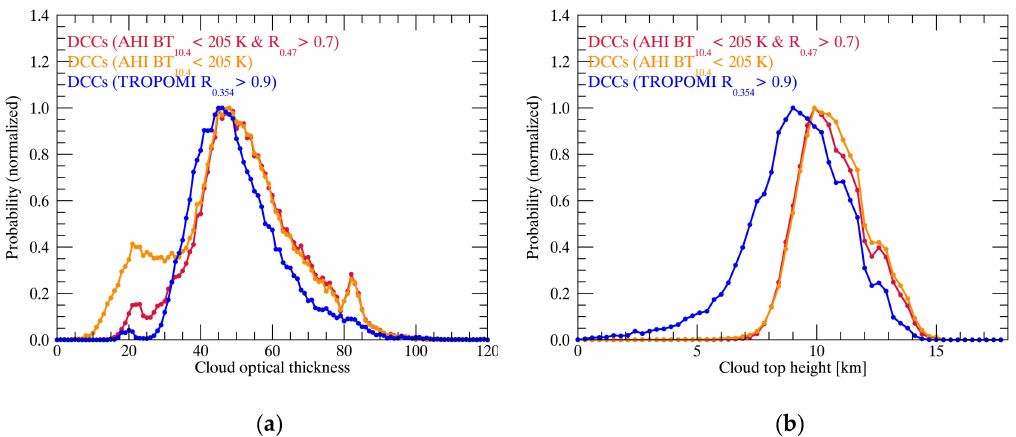
Figure 14. Same as Figure 13 for histograms of ( a ) cloud optical thickness and ( b ) cloud top height from the TROPOMI Level -2 cloud product for